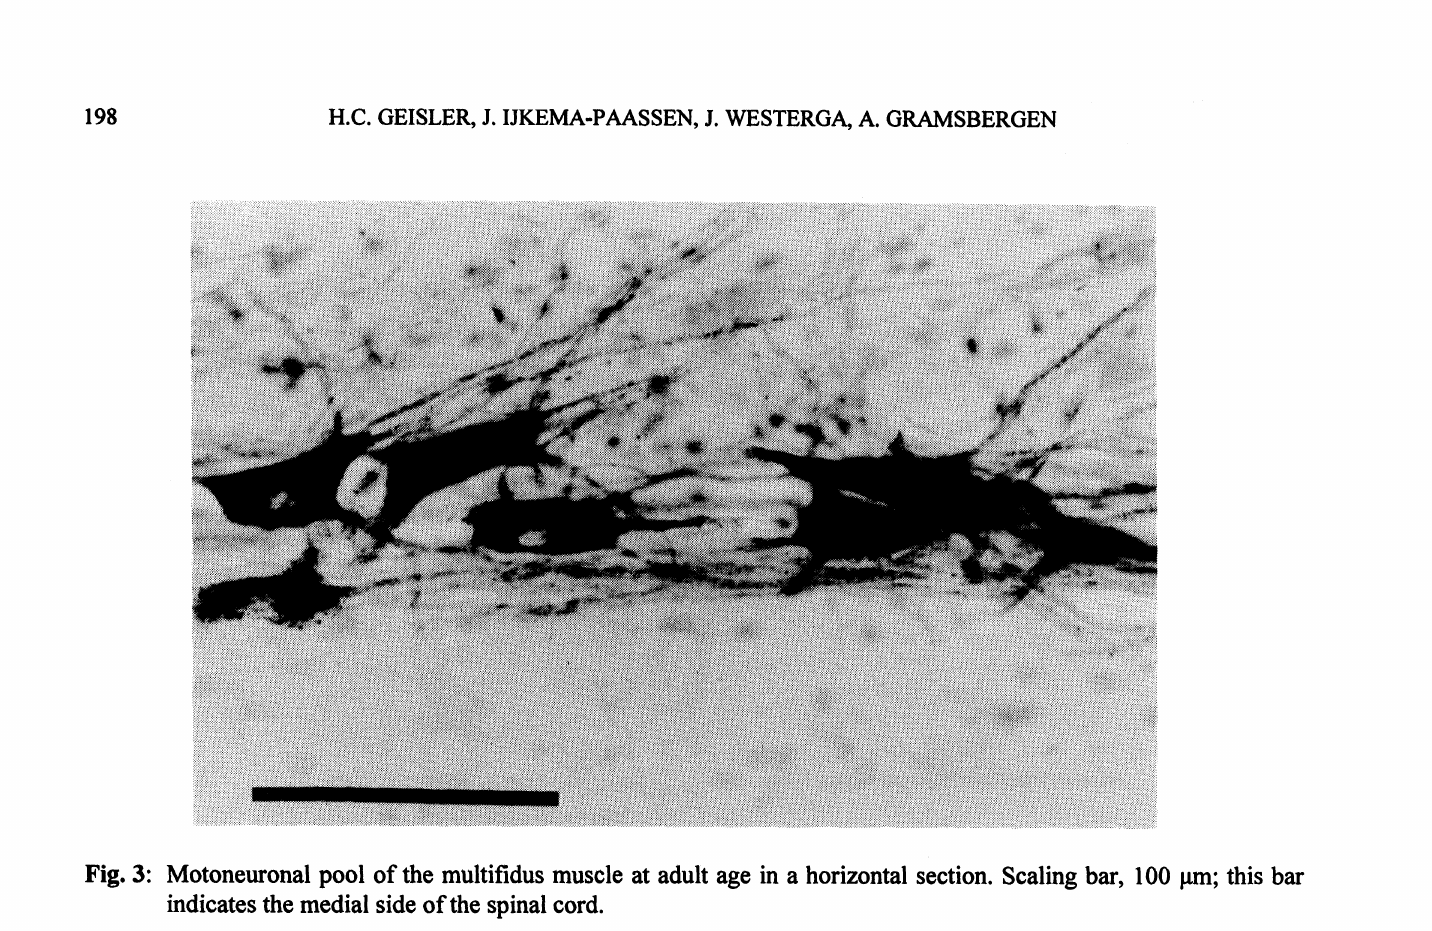
Fig. 3" Motoneuronal pool of the multifidus muscle at adult age in a horizontal section. Scaling bar, 100 Ixm; this bar indicates the medial side ofthe spinal